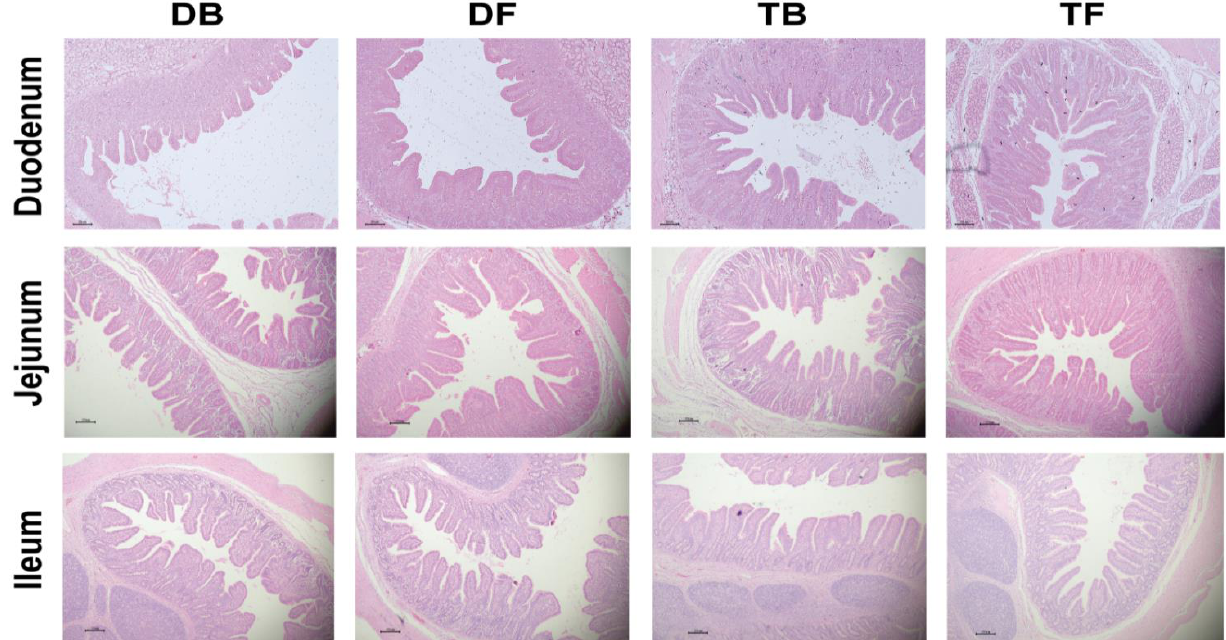
Figure 1. Effect of DF on intestinal morphology in different pig breeds (H&E; × 40). DB, Durocs were exposed to basal diet; DF, Durocs were exposed to high-fiber diet; TB, Taoyuan pigs were exposed to a basal diet; TF, Taoyuan pigs were exposed to a high-fiber diet. Table 4. Effects of DF on intestinal morphology.